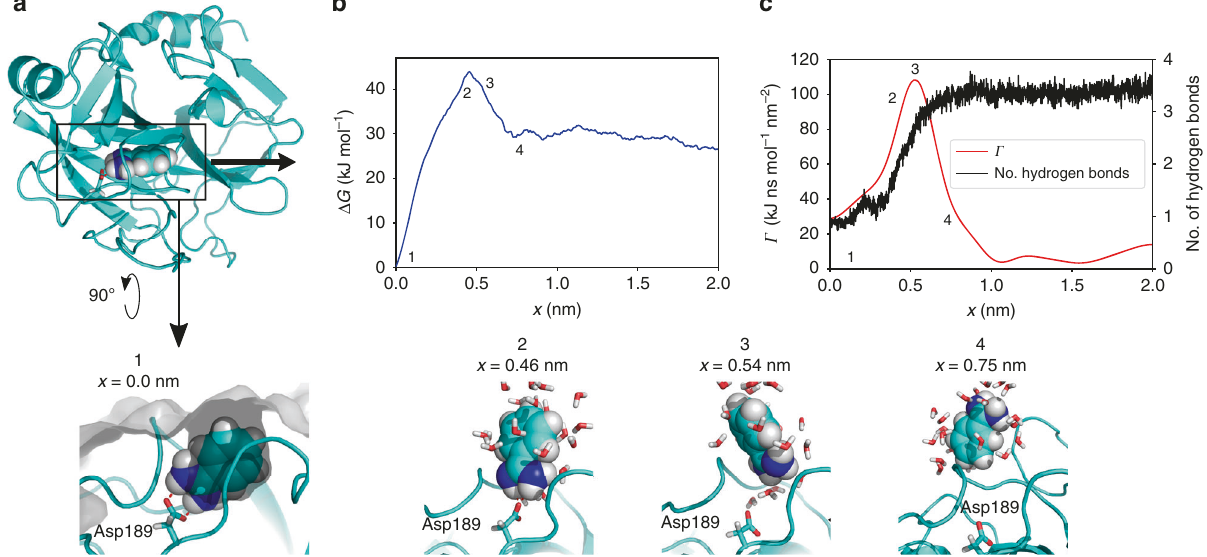
Fig. 3 Unbinding of benzamidine from trypsin. a TMD snapshots of the structural evolution in trypsin along the dominant dissociation pathway, showing protein surface in gray, benzamidine as van der Waals spheres, Asp189 and water molecules as sticks. Benzamidine is bound to the protein in a cleft of the protein surface via a bidental salt bridge to Asp189. dcTMD calculations of b free energy Δ G ( x ), and c (Gaussian smoothed) friction Γ ( x ) together with the mean number of hydrogen bonds between benzamidine and water. Highlighted are the bound state 1, transition state 2, the state with maximal friction 3 and the unbound state 4. Error bars of free energy and friction estimates are given in Supplementary Fig.